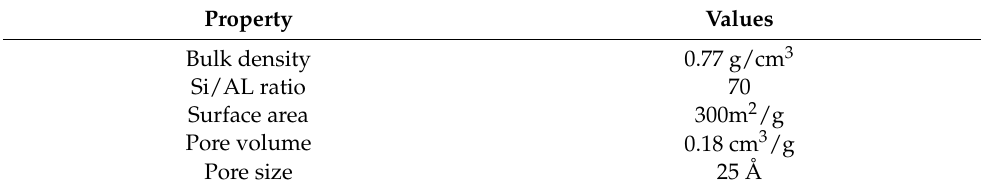
Table 4. Catalyst properties.